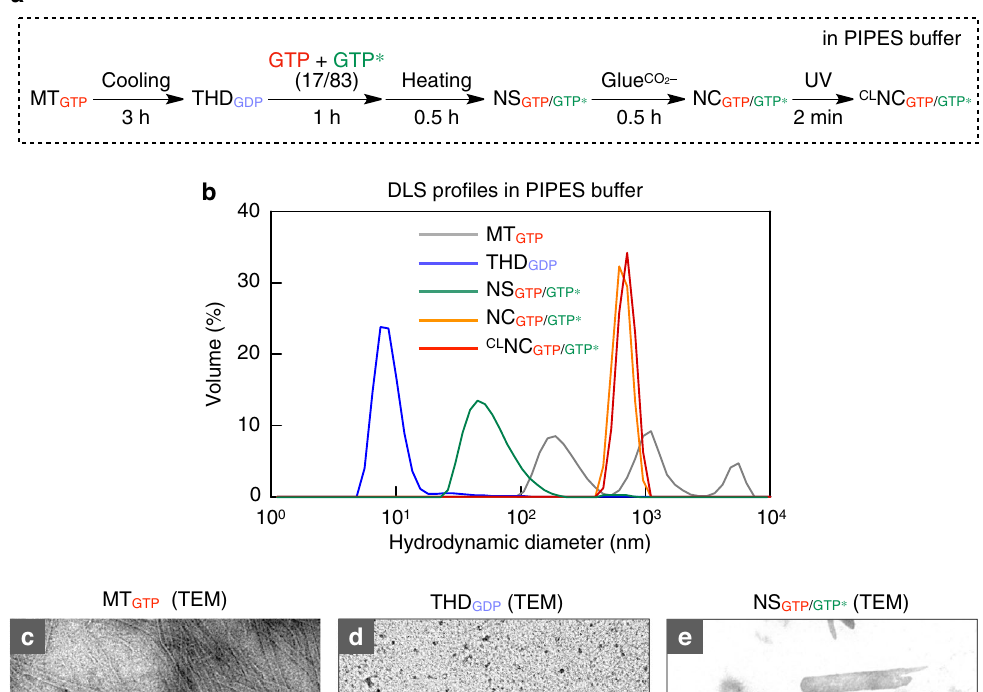
Fig.2|ReconstitutionofMTinto CL NC GTP/GTP* .a Atypicalsyntheticprocedurefor the preparation of CL NC GTP/GTP* . b DLS pro fi les of MT GTP (gray), THD GDP (blue), NS GTP/GTP* (green), NC GTP/GTP* (orange), and CL NC GTP/GTP* (red) in PIPES buffer. c – e TEM images of MT GTP (5.8mgml – 1 ; c ), THD GDP (0.3mgml – 1 ; d ), and NS GTP/GTP*